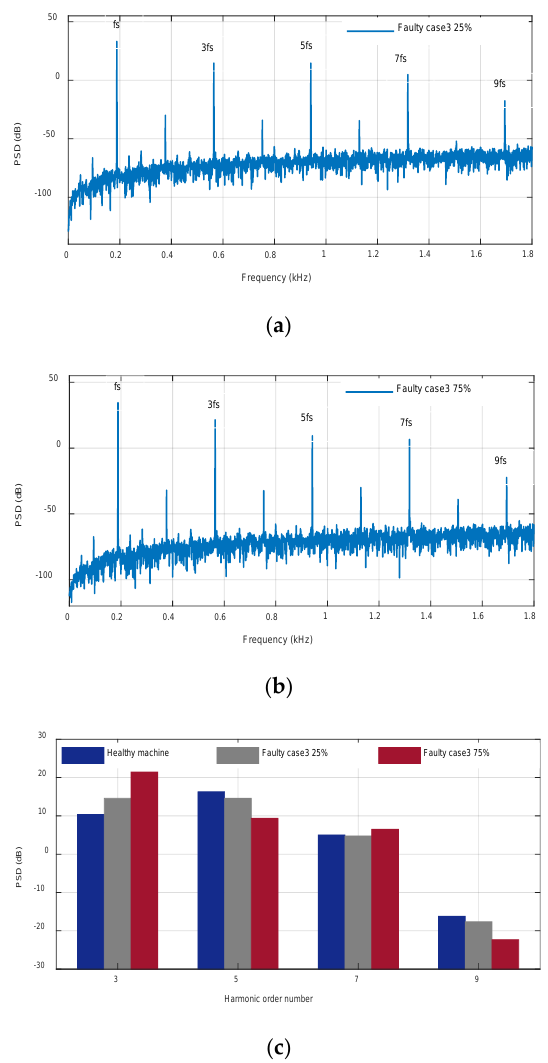
Figure 25. Faulty case 3: ( a ) PMSM current spectra normalized plot under 25%; ( b ) PMSM current spectra normalized plot under 75%; ( c ) ASBCs harmonics variations.